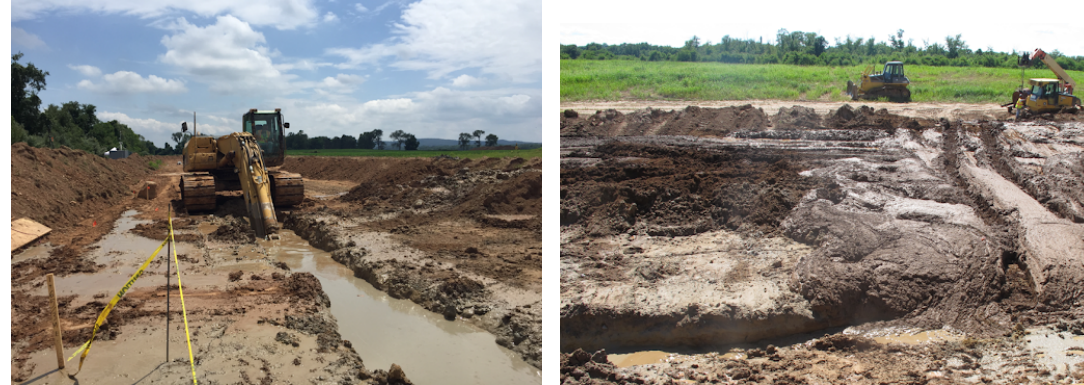
Figure 1. Illustration of the excavation and backfill process to construct a soil-bentonite slurry trench cutoff wall [2].